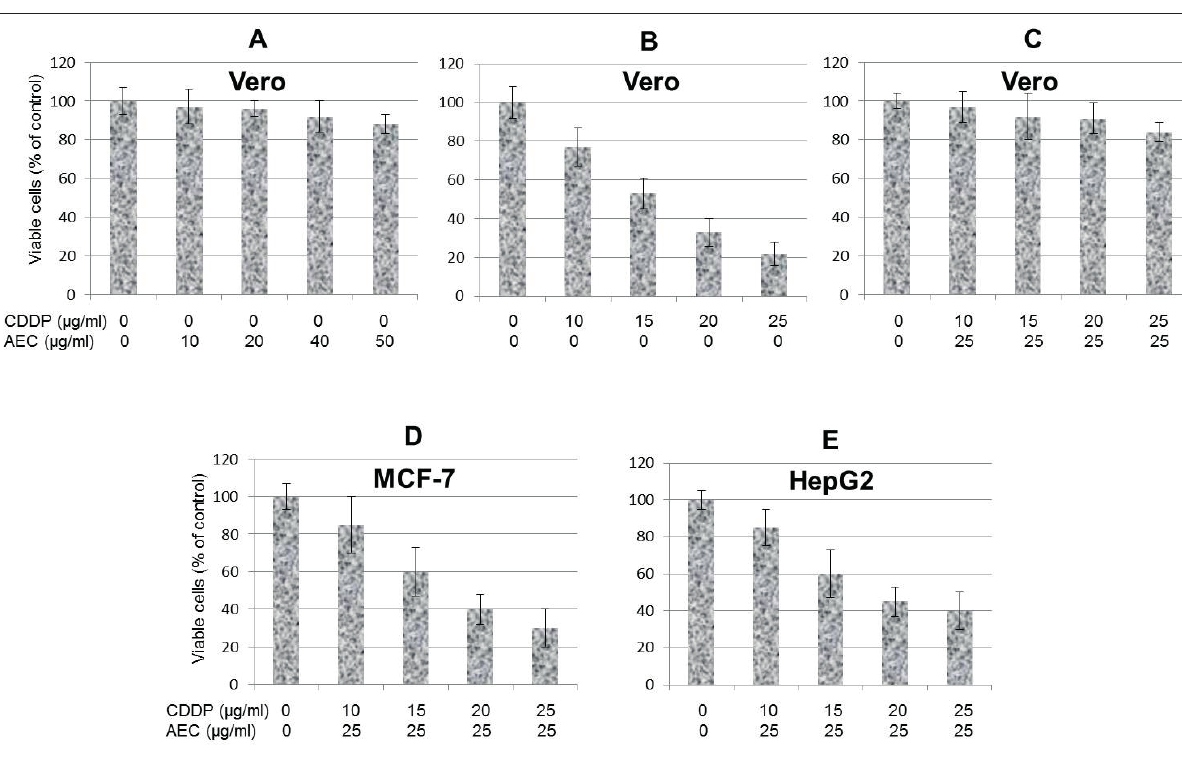
Fig. 1c, pre-incubation of the cells with aec significantly increased the percentage of cell viability. The cytoprotec- tive effects of aec during cddp treatment were dose- dependent, and significant cytoprotection was shown at 10-50 µg/ml (Fig. 1c). These finding suggests that the treatment of Vero cells by aec may play a key role in the protection against cddp mediated toxicity.